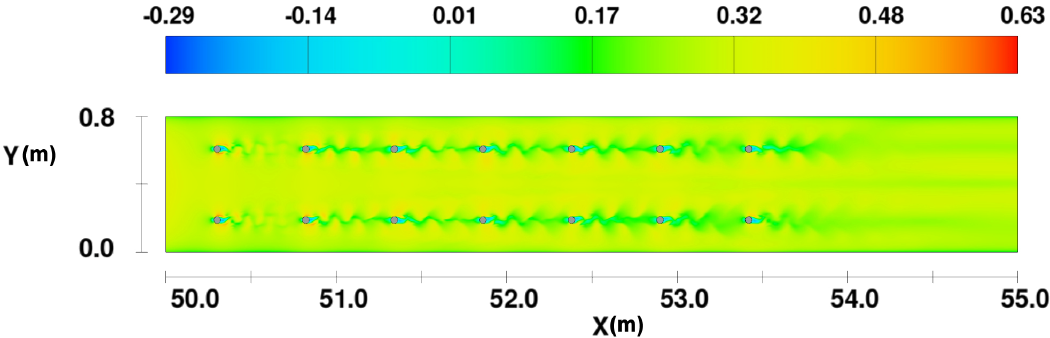
Figure 9. The profiles of x-velocity in x-y at z = 0.002 m and different times with a span of 0.52 m. 219 At the beginning (t = 4 s), the flow patterns and characteristics around each pier developed 220 individually. Initially, the velocity in front of the pier reduced due to the blocking of water by 221 each pier. The same observation was made when simulating a single pier. When the flow 222 bypassed the pier, the velocity on both sides of the pier increased rapidly, which caused the 223